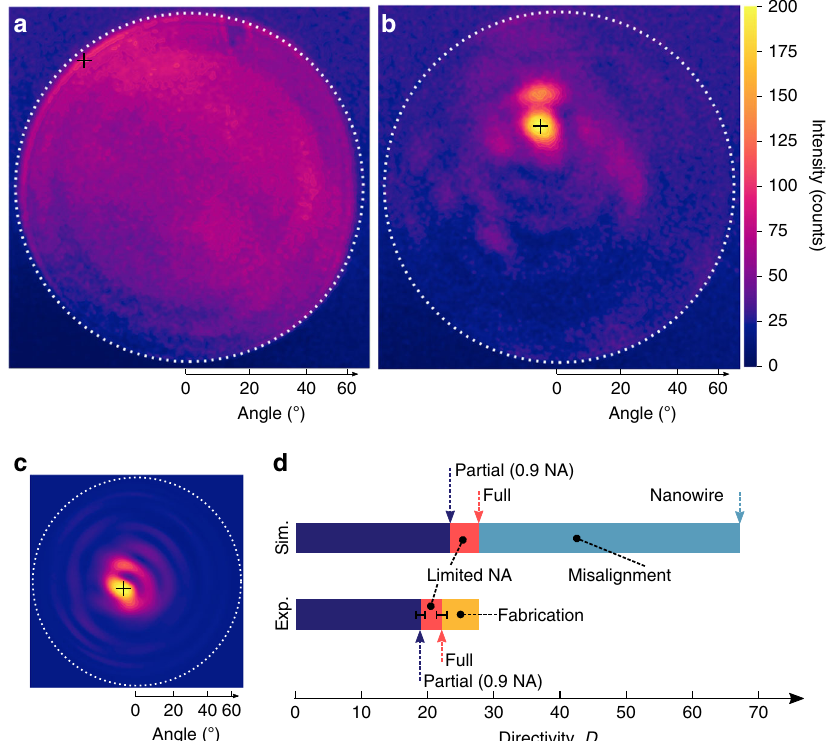
Fig. 4 Fourier microscopy images of nanowire photoluminescence. a Angular distribution image of nanowire PL of a coated nanowire with no lens structure present, showing nearly homogeneous illumination, contrasted to b angular distribution image nanowire PL with a nanolens present, showing directional beaming into a half-angle of 3.5°. Dashed white lines represent the 0.9 NA objective collection area, and the black “ + “ indicates the maximum emission direction. c Simulated measurable (0.9 NA) angular distribution of the nanowire – nanolens system including the in fl uences of misalignment and the fi nite source, beaming into a half-angle of 3.1°. d Attribution of likely mechanisms responsible for the difference between the experimentally measured and full simulated directivity, with arrows indicating the partial (within the measurable 0.9 NA) directivity and full directivity, along with the directivity of